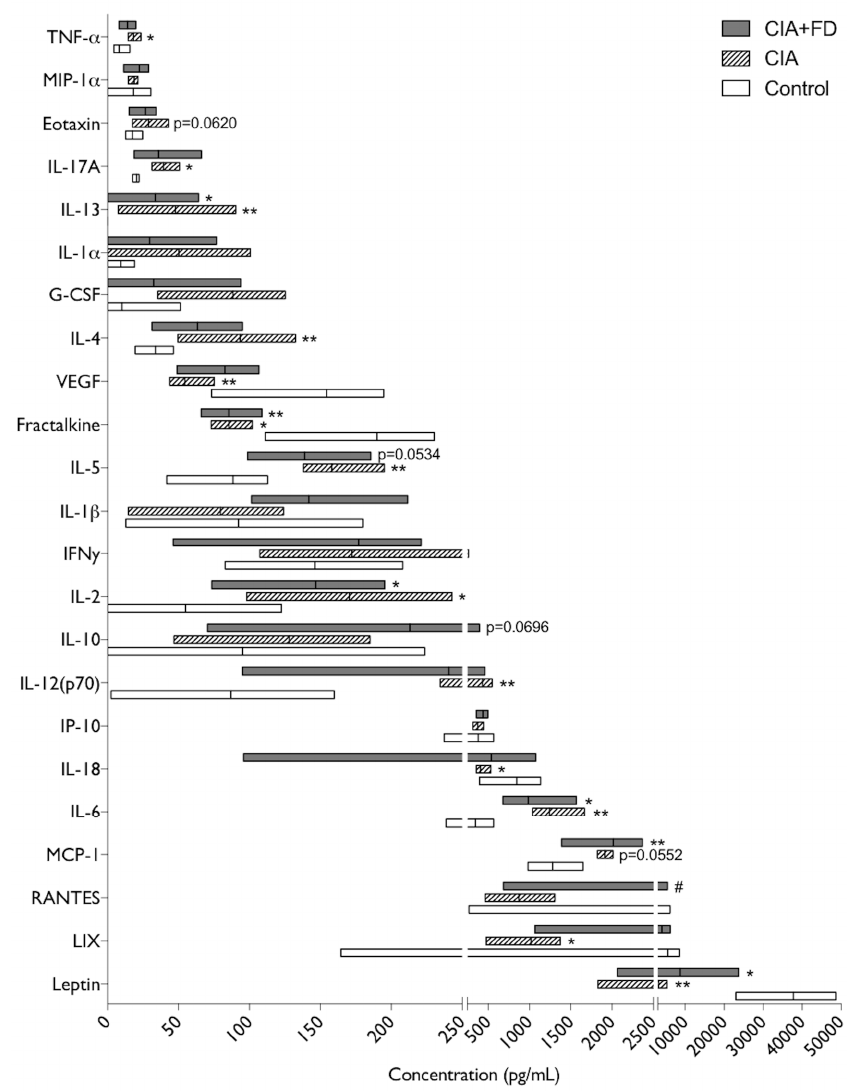
Figure 4. Changes in plasma cytokine and chemokine profile in CIA and CIA+FD. Quantitative results of the multiplex cytokine/chemokine array performed for all animals in each group. Box plots represent min-to-max distribution of n = 4 to 5 animals per group. * p < 0.05, ** p < 0.01 in relation to control group, and # p < 0.05 relatively to CIA group, determined by Kruskal–Wallis test and Dunn’s multiple comparisons test.